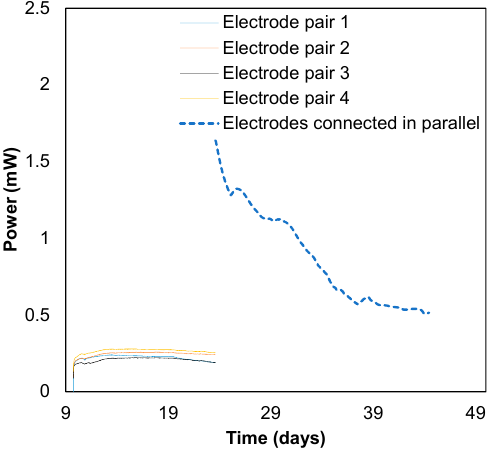
Figure 3. Power production by the biobattery. Between days 9–24 each anode-cathode pair was connected to a 1000 Ohm external resistance. From day 24 onward all anode-cathode pairs were connected in parallel and power production was optimized with the P/O algorithm.